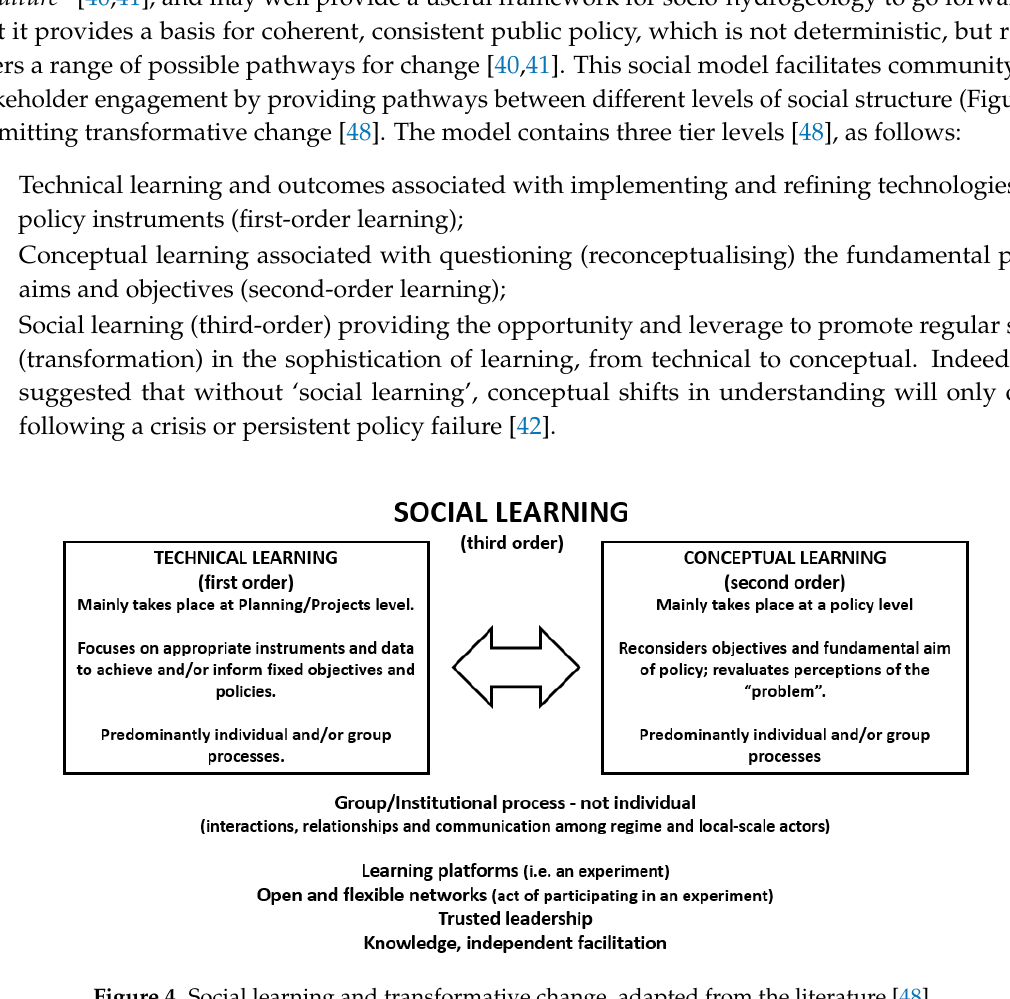
Figure 4. Social learning and transformative change, adapted from the literature [48].